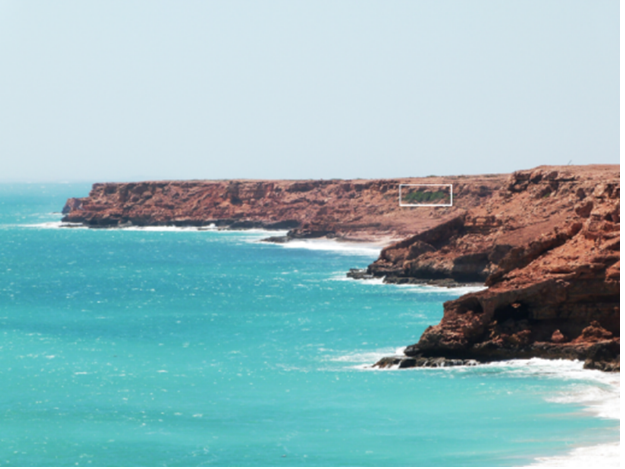
Figure 2. Photograph of Boodie Cave highlighting southwest entrance (Photograph by Peter Veth).